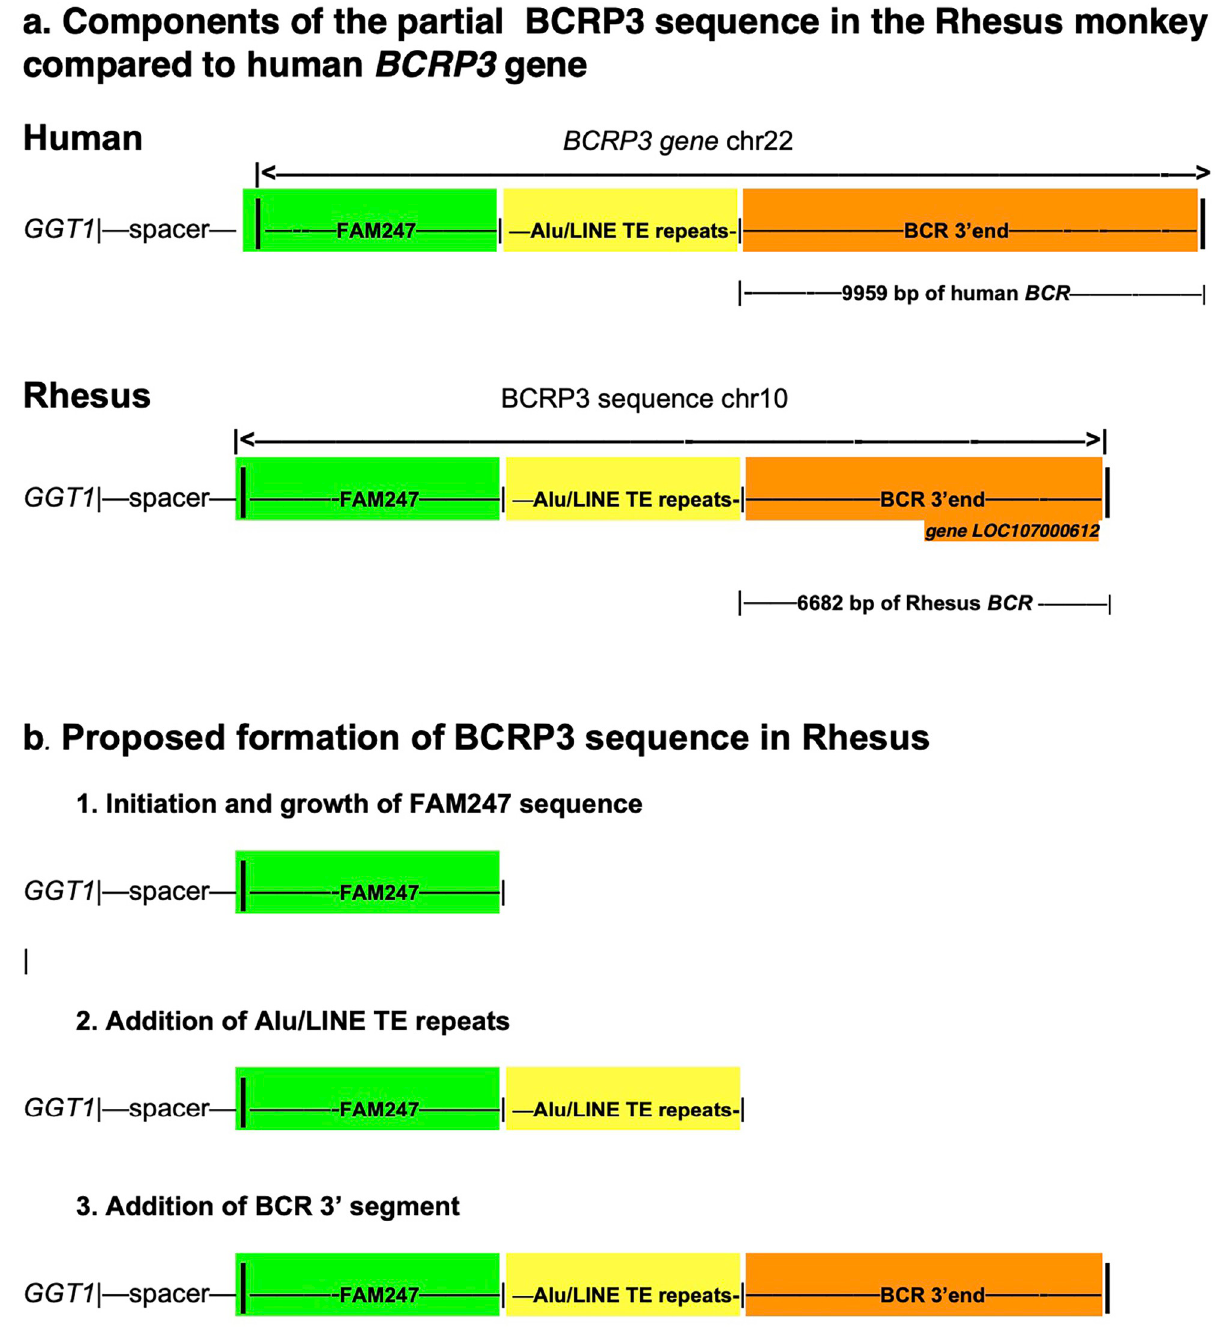
Fig 5. a. A schematic of the composition of the BCRP3 sequence in Rhesus compared to that of the human BCRP3 gene. b. The proposed formation of the BCRP3 sequence in Rhesus, with three steps that involve initiation of synthesis and sequence growth, followed by addition of a complex of TE motifs and ending with addition of a segment of a gene from another part of the